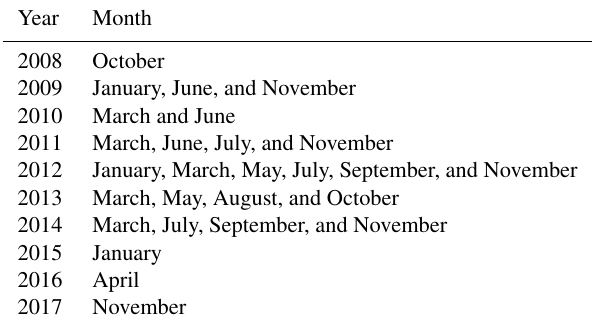
Table 2. Table showing the year and the months in which the LPC data were included in this study. Each month represents one LPC flight with stratospheric